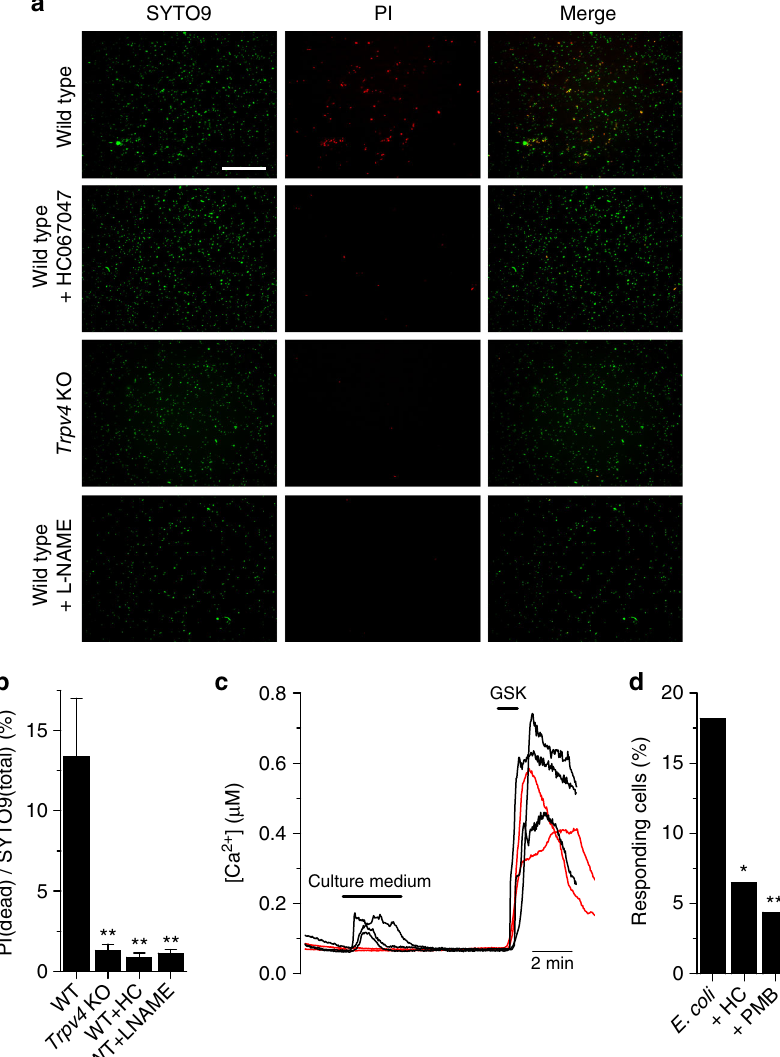
Fig. 6 TRPV4-induced NO exerts direct anti-bacterial effect. a Representative images of E. coli bacteria stained with SYTO9 (green, all cells) or PI (red, dead cells). Magni fi cation, ×40. Bacteria were imaged after 2 h incubation with a monolayer of mTEC isolated from WT or Trpv4 KO mice. The TRPV4 antagonist HC067047 (10 μ M) or the NOS inhibitor L-NAME (1 mM) were added 15 min prior to the bacterial challenge. Scale bar, 50 μ m. b Percentage of dead cells (red/green) after co-culture with mTEC isolated from WT or Trpv4 KO mice ( n ≥ 5). c Intracellular Ca 2+ response of TRPV4-transfected HEK239T cells to the supernatant of a 0.1 OD culture of E. coli . GSK1016790A, 10 nM. d Percentage of TRPV4-expressing HEK293T cells responding to supernatant of 0.1 OD culture of E. coli . The TRPV4 inhibitor HC067047 (HC, 10 μ M) was perfused 2 min prior to addition of bacterial supernatant. The LPS scavenger Polymyxin B (PMB, 300 µ g ml − 1 ) was pre-incubated during 30 min with the bacterial supernatant. * P < 0.05; ** P < 0.01, Fisher ’ s exact